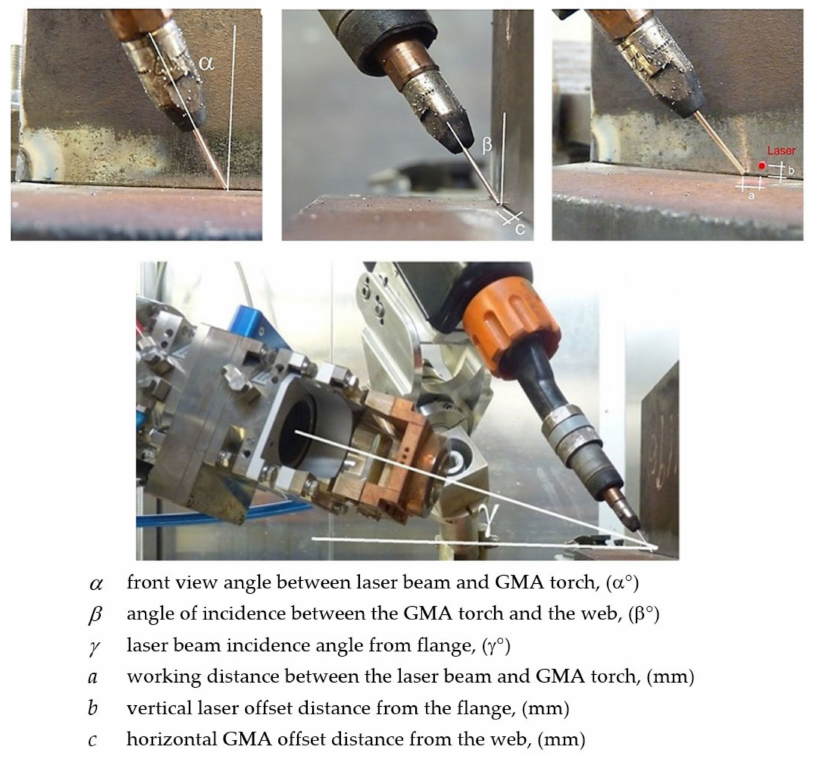
Figure 3. Geometric configuration of the laser and GMA sources to